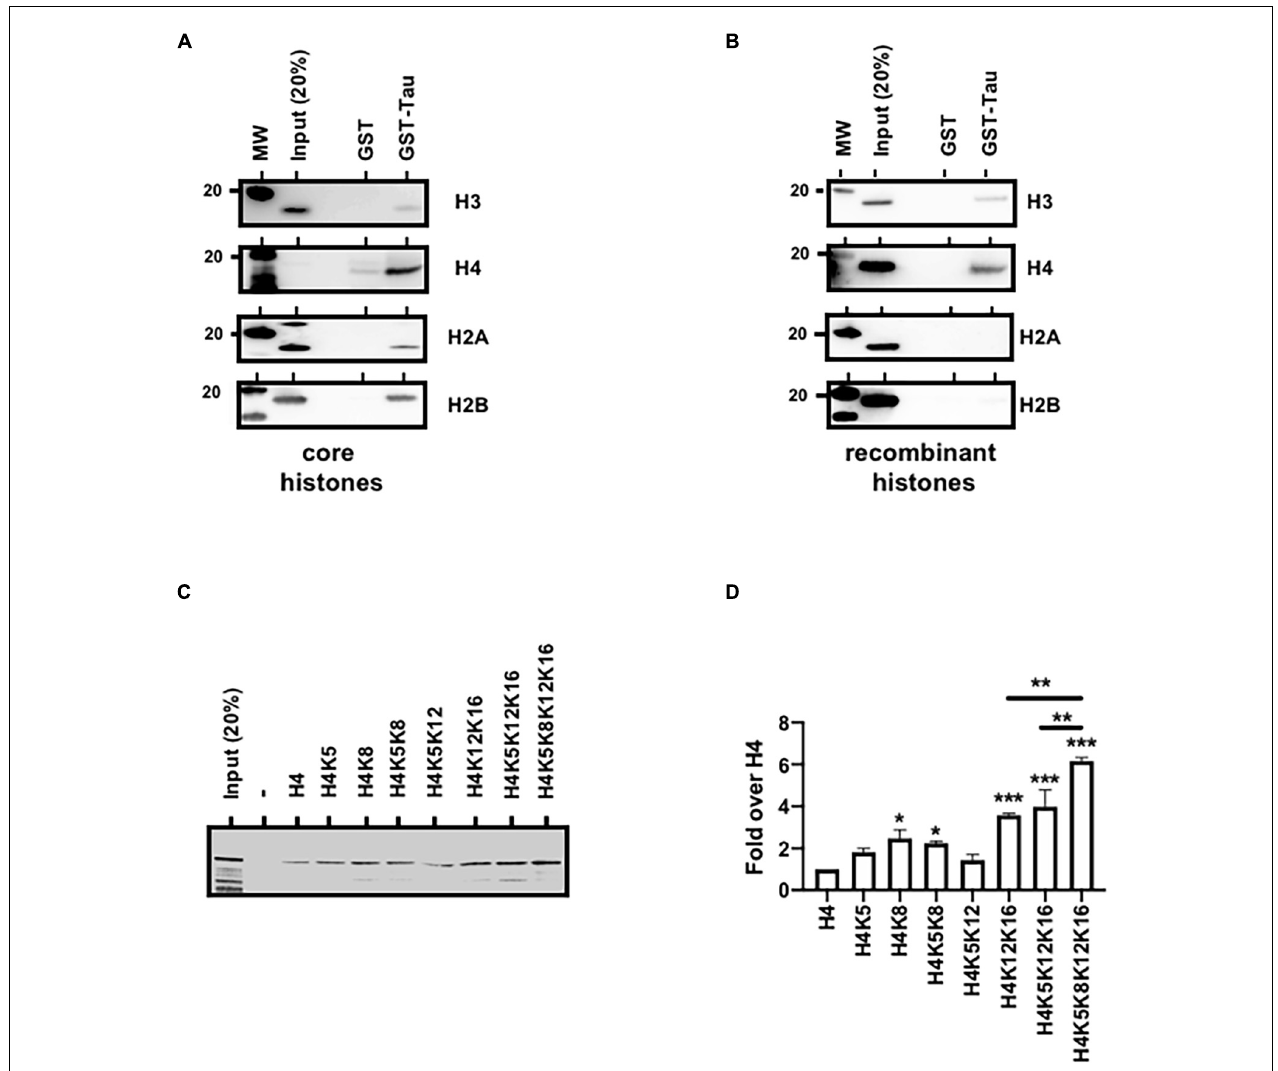
FIGURE 5 | Tau4R binds directly to histones. (A) Tau4R interacts with core histones. GST-pulldown experiments were carried out using GST (1 µ g) or GST-Tau4R (1 µ g) and purified core histones (1 µ g). Complexes were precipitated with Sepharose-glutathione beads, resolved by 12% SDS-PAGE and visualized by immunoblot analysis with antibodies against H3, H4, H2A, and H2B. (B) Tau4R interacts with histone H3 and H4. GST-pulldown experiments were carried out using 1 µ g of GST or GST-Tau4R and 1 µ g of recombinant H3, H4, H2A, or H2B. Complexes were precipitated with Sepharose-glutathione beads, resolved by 12% SDS-PAGE and visualized by immunoblot analysis with antibodies against H3, H4 H2A, or H2B. (C) Histone H4 tail peptides tested for Tau binding. Tau protein bound to biotinylated synthetic H4 peptides was detected by immunoblot. A representative western blot is shown and (D) is a quantification from three independent experiments. Data are mean ± SD, * P < 0.05, ** P < 0.01, *** P <